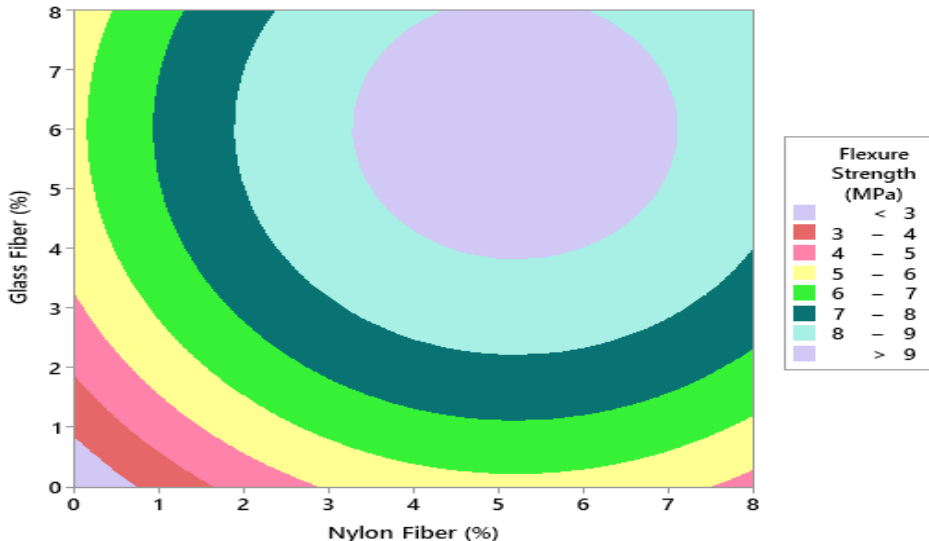
Figure 13. Contour plot for flexural strength. 4.5. Modulus of Elasticity